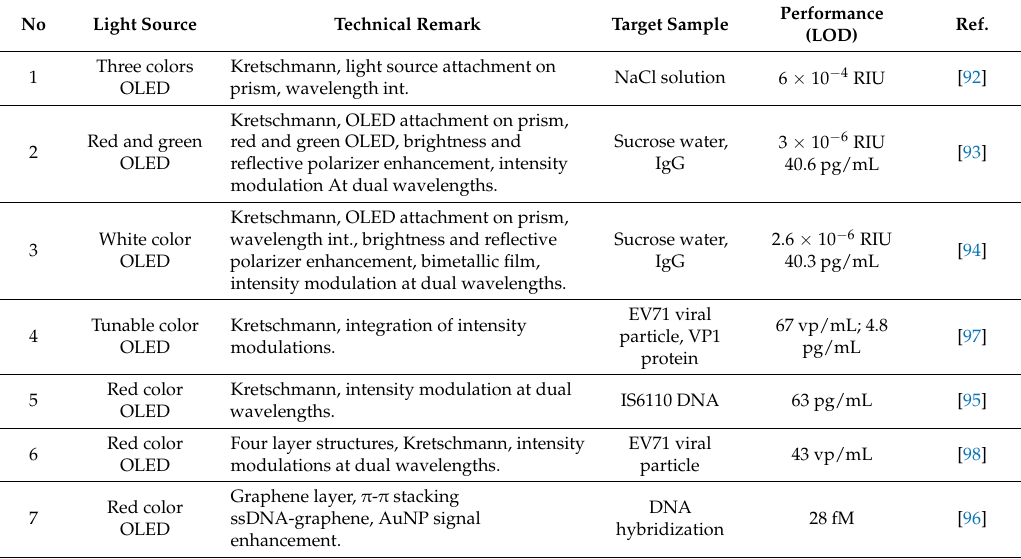
Table 5. The summary of OLED light source in SPR sensor